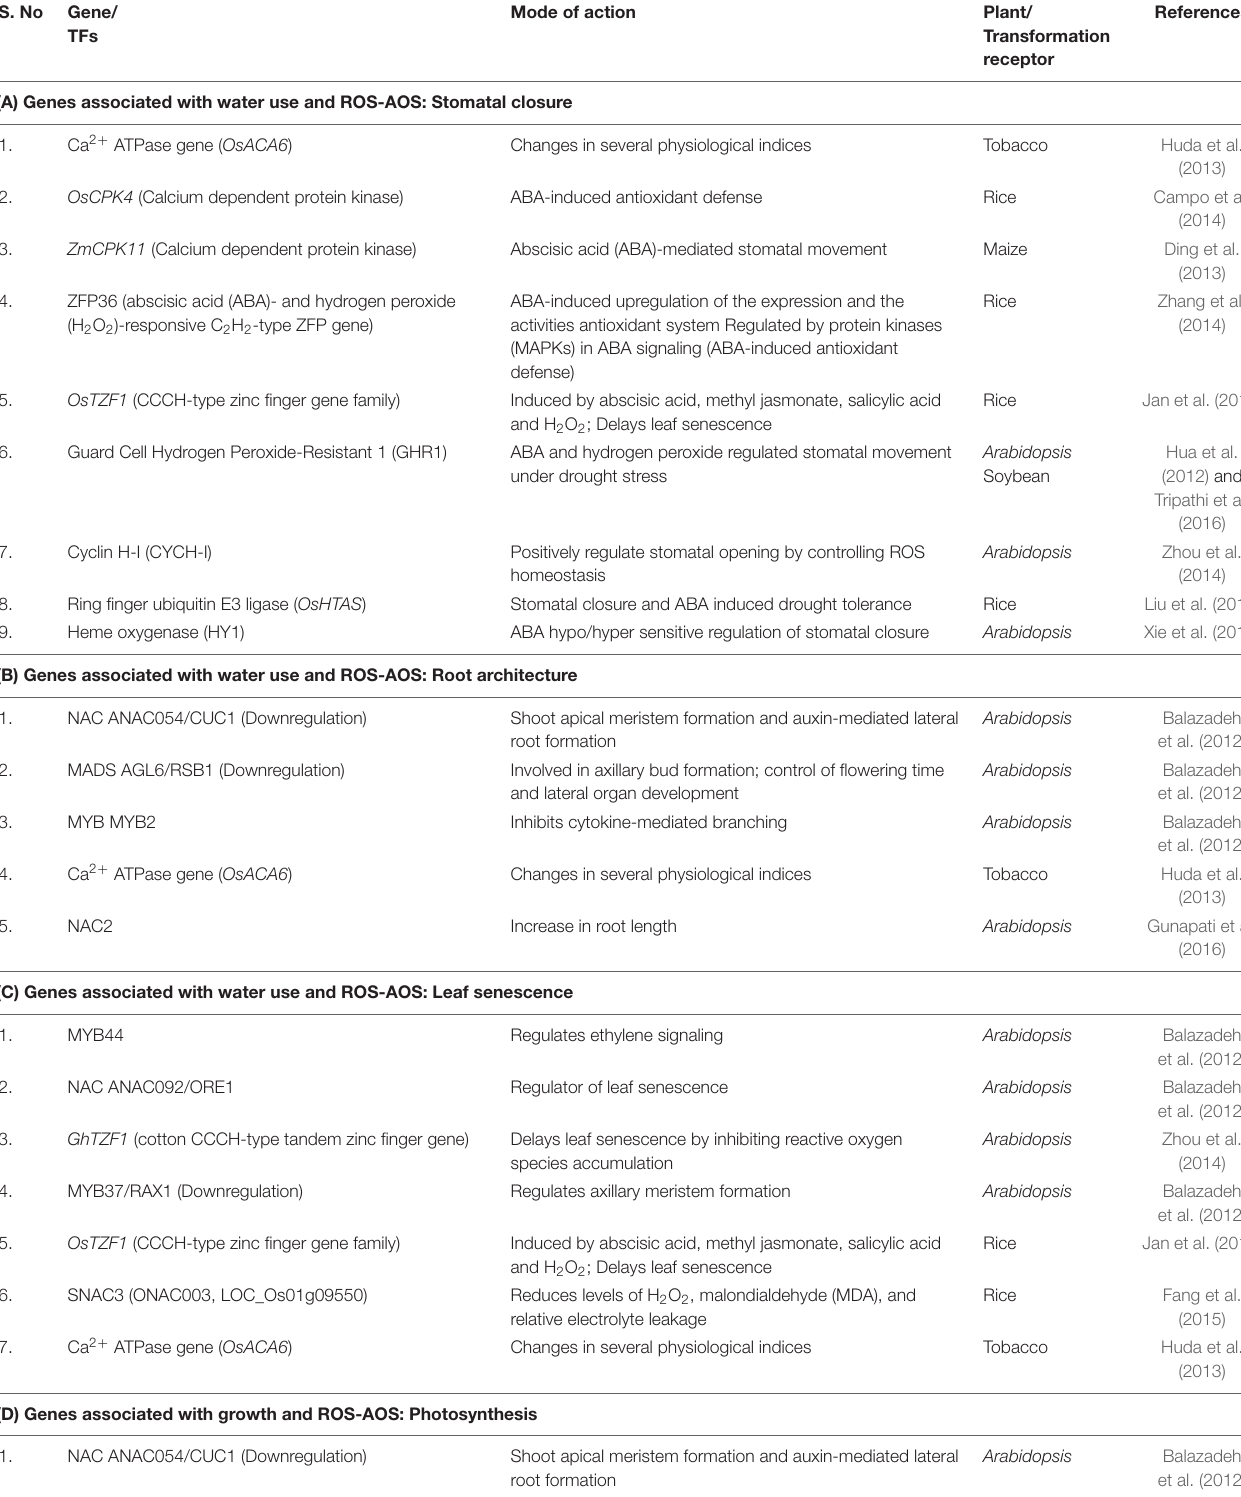
TABLE 1 | Some of the ROS-AOS genes associated with processes governing water use and biomass production. S. No Gene/